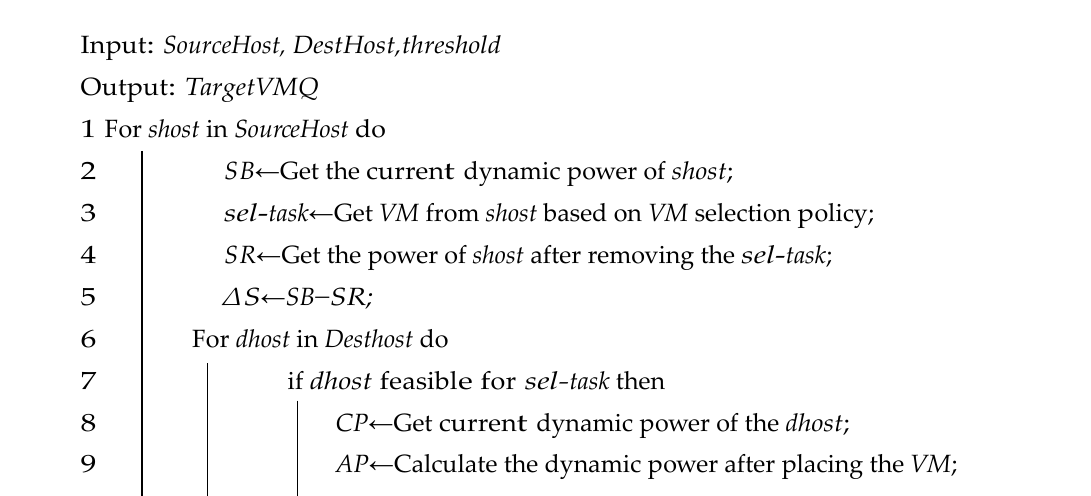
(including cooling load, lighting and others). The CPU power consumption of all the servers should not exceed 23kW Algorithm 6: Proposed task distribution algorithm (TDA)